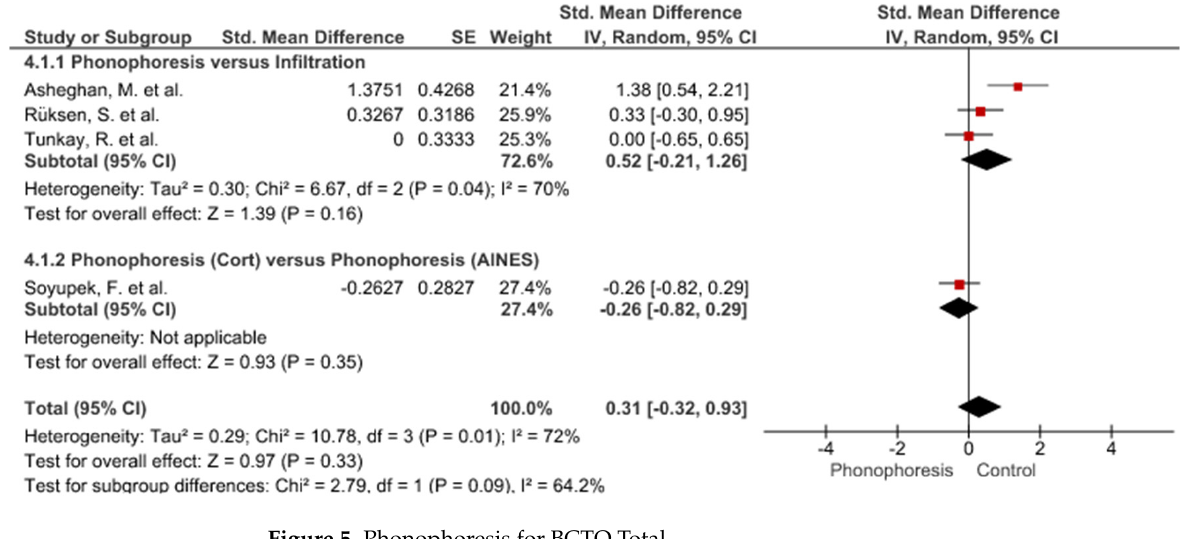
Figure 5. Phonophoresis for BCTQ Total.